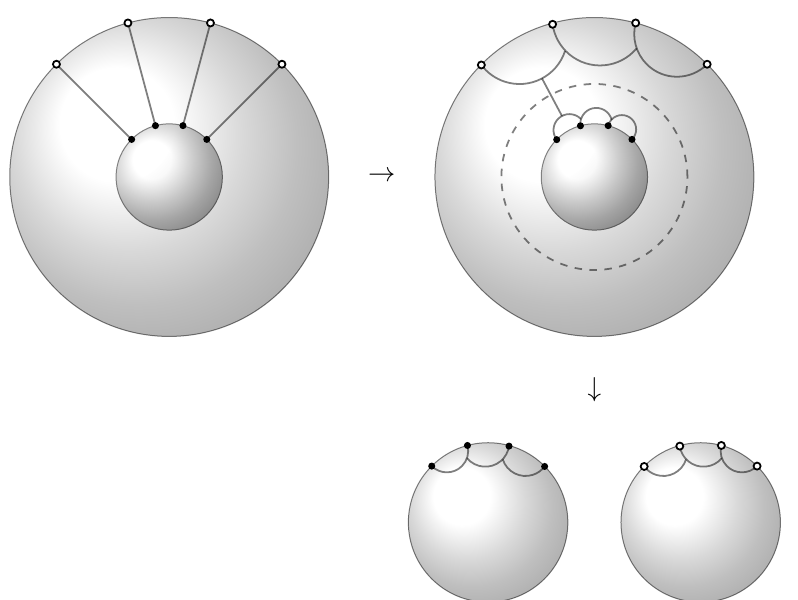
Figure 2 . The conformal block decomposition of the four-point function of the holomorphically- defect-factorized local operator